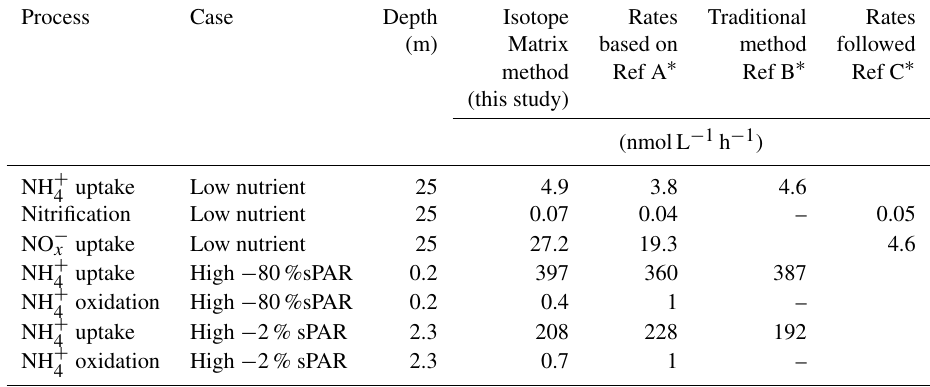
/ NO − x uptake and NH + oxidation/nitrification rates derived from different methods. 4 4